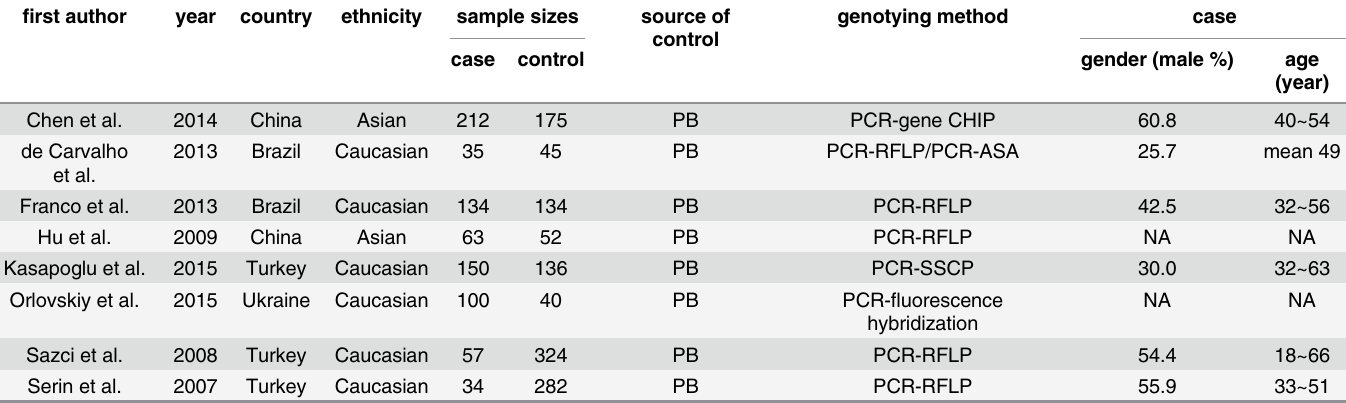
Table 1. Characteristics of eligible studies in